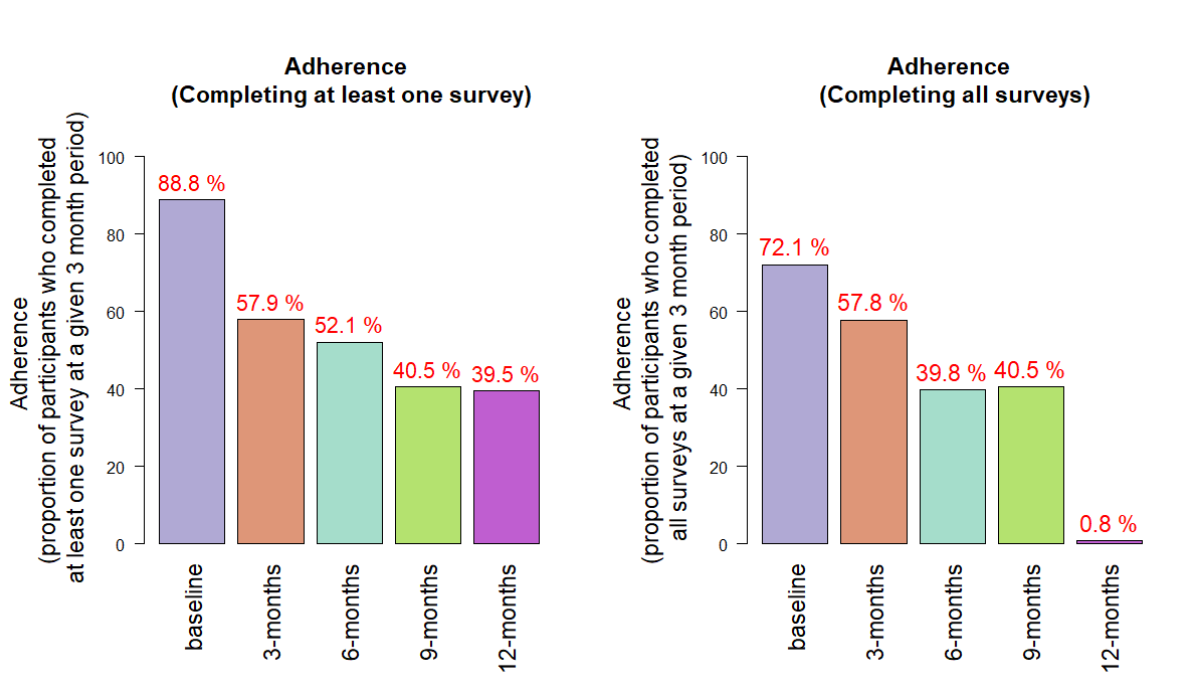
Figure 2. Proportion of eCohort Framingham Heart Study (eFHS) participants who completed at least one survey (left panel) and all surveys (right